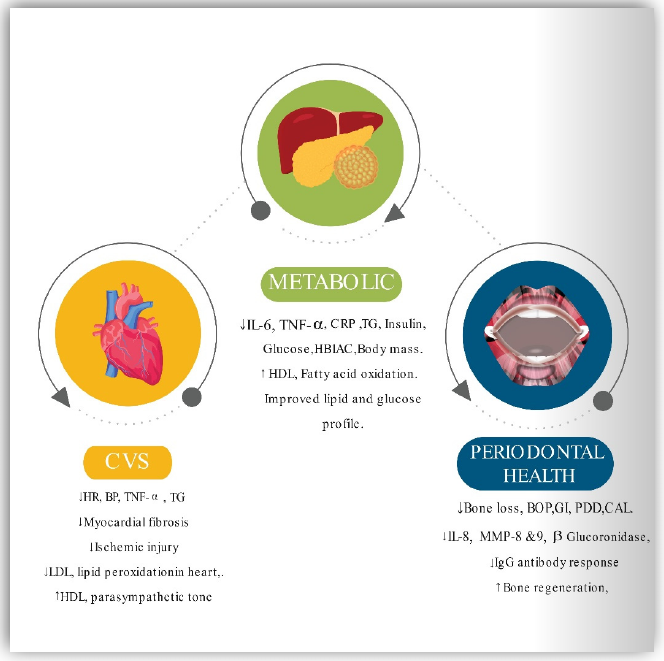
Figure 4. Schematic representation of the effect of intermittent fasting on CVS, Metabolic and Peri- odontal health. CRP—C-reactive protein, HDL—High-density lipoprotein, LDL—low-density lipo- protein, IL-6 Interleukin-6, Hb1Ac—Hemoglobin A1c, BOP—bleeding on probing, PPD—probing pocket depth, GI—Gingival index, CAL—clinical attachment loss, IgG—Immunoglobulin, BW— body weight, BMI—body mass index, WC—waist circumference, FGLU—fasting glucose, TRG—